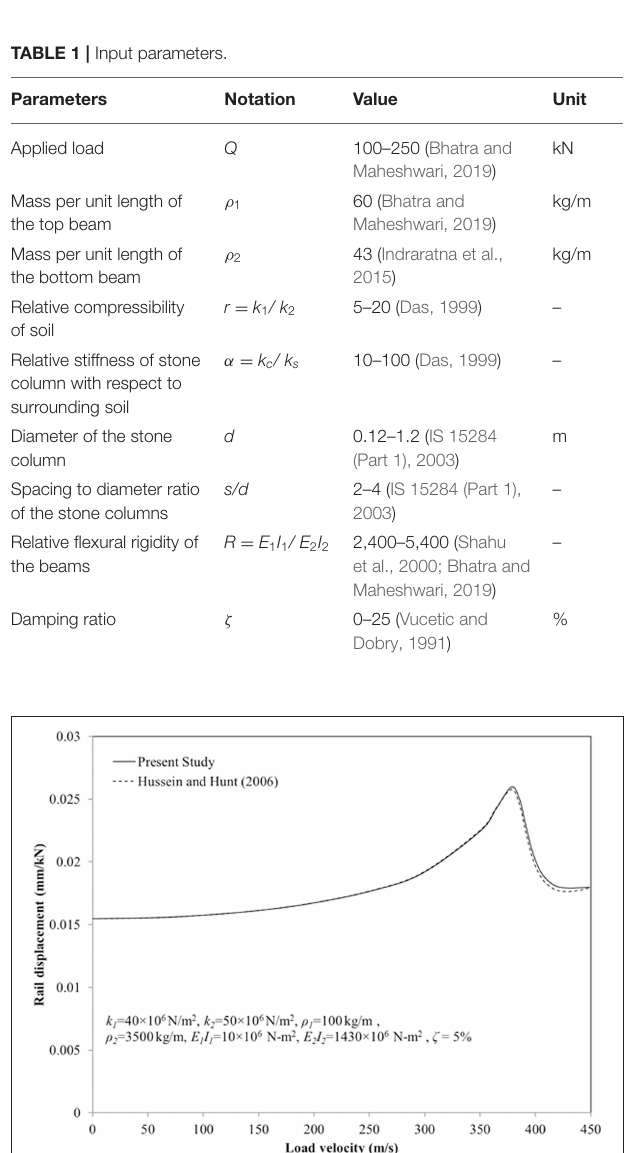
top beam for the parameters: Q = 175 kN, v = 36 m/s, k 1 =